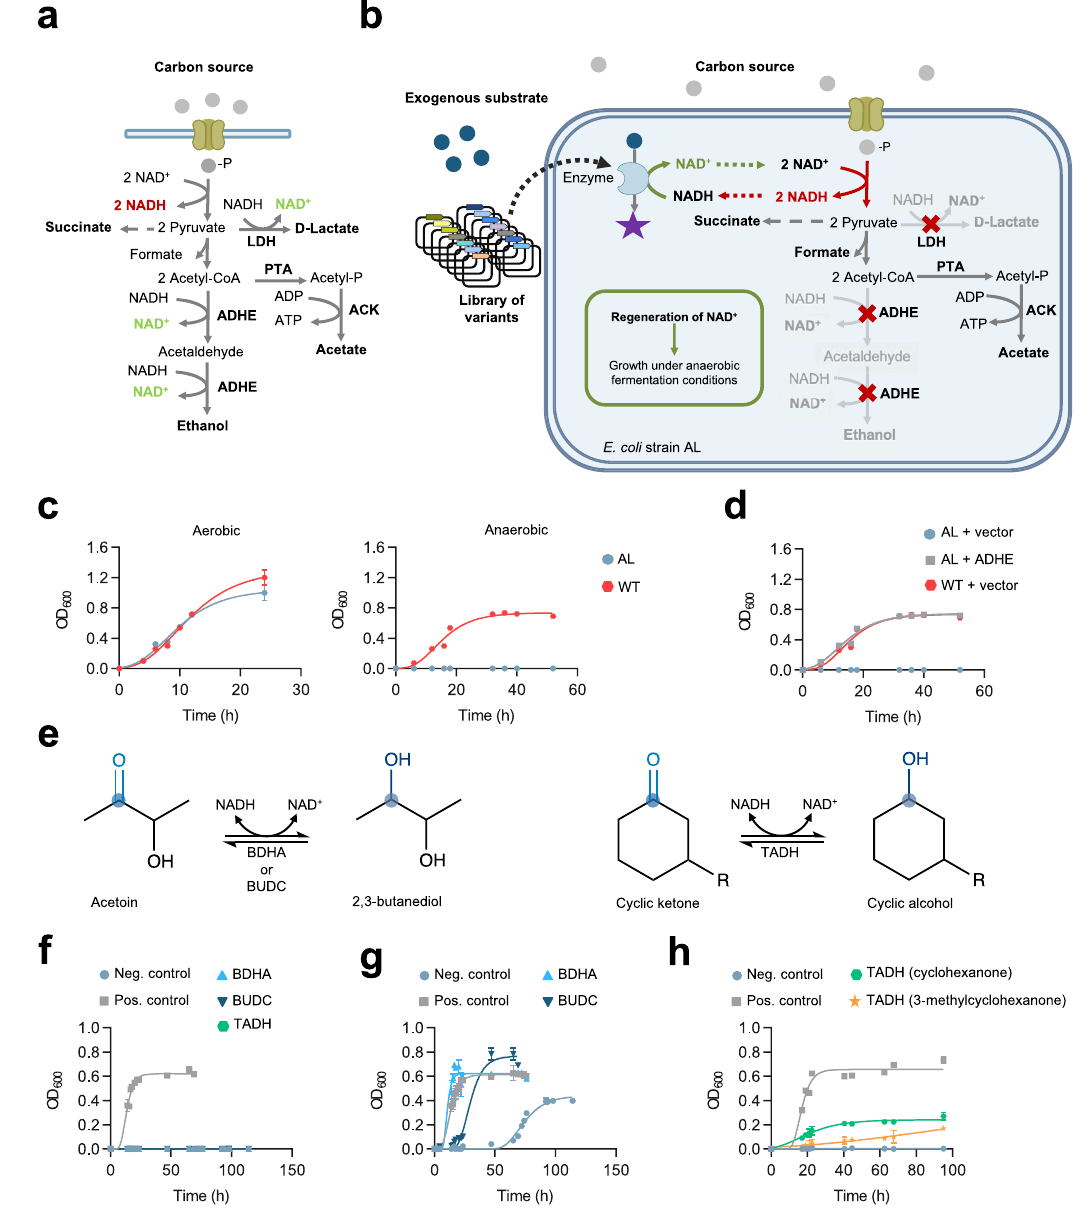
Fig. 1 Principle and validation of redox-directed in vivo evolution. a E. coli anaerobic fermentation pathways. In anaerobic fermentation, reduction of pyruvate to ethanol and/or lactate regenerates NAD + required for glycolysis and growth. b E. coli strain AL lacking ADHE (bifunctional alcohol-aldehyde dehydrogenase) and LDH (lactate dehydrogenase) cannot regenerate NAD + , so cannot grow by anaerobic fermentation. Under anaerobic fermentation conditions, selection pressure to restore NAD + regeneration and hence growth can be used to select variants from libraries, such as enzyme variants active with non-natural substrates. c Cultures of WT and AL cells in M9 glucose medium under aerobic or anaerobic conditions. d Transformation with ADHE (pLS1, hereafter ‘ Pos. control ’ ) but not vector (pUC19, hereafter ‘ Neg. control ’ ) restores anaerobic growth of AL cells in M9 glucose to WT levels. e Foreign enzyme-substrate pairs used as proof of concept of the selection system. f AL cells transformed with BDHA ( Bacillus subtilis acetoin reductase; pLS2), BUDC ( Klebsiella pneumoniae acetoin reductase; pLS3), or TADH ( Thermus sp. ATN1 alcohol dehydrogenase; pLS12) do not grow anaerobically in M9 glucose medium without the oxidized substrate of each oxidoreductase. Addition of acetoin ( g ) or cyclohexanone or 3-methylcyclohexanone ( h ) to the culture medium restored anaerobic growth in M9 glucose medium of AL cells transformed with BDHA or BUDC ( g ) or TADH ( h ). Data points of growth curves represent mean values, with error bars showing standard deviation; n = 3 biologically independent cultures for all timepoints of growth curves. Source data are provided as a Source Data fi